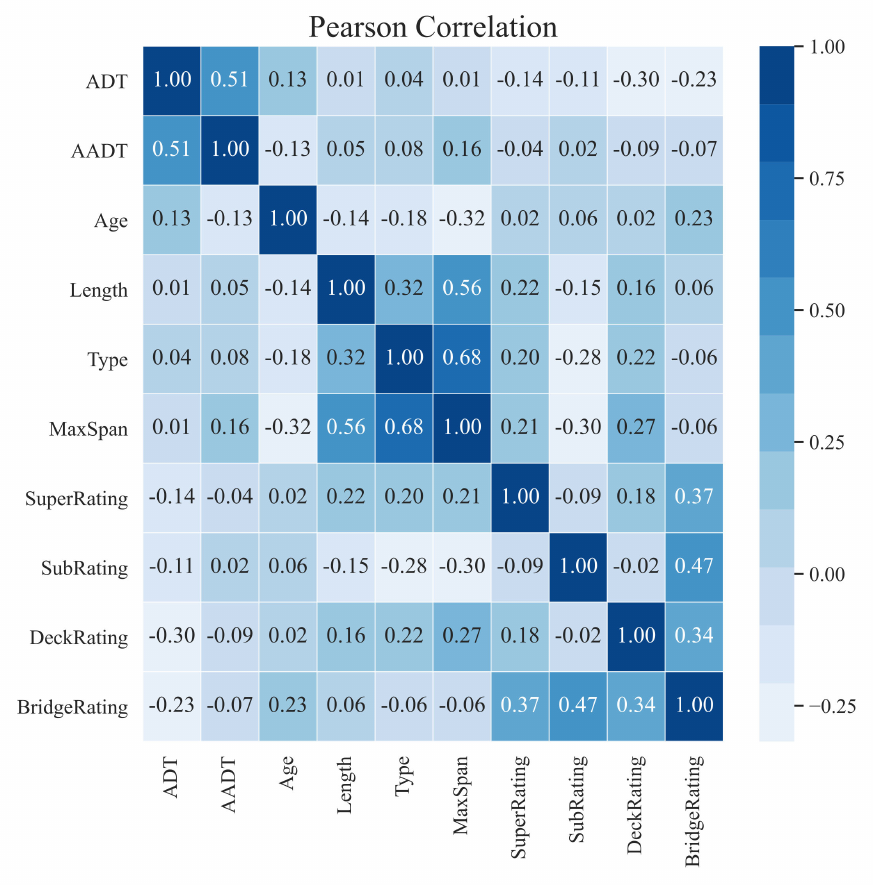
Figure 9. Pearson correlation matrix of selected